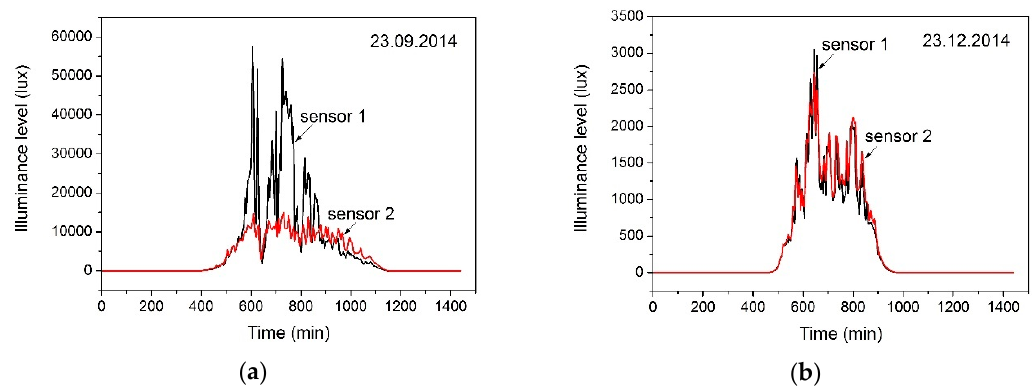
Figure 4. Illuminance levels of daylight measured by the weather station (sensor 1) and brightness sensor (sensor 2) on a sunny day ( a ) and an overcast day ( b ).